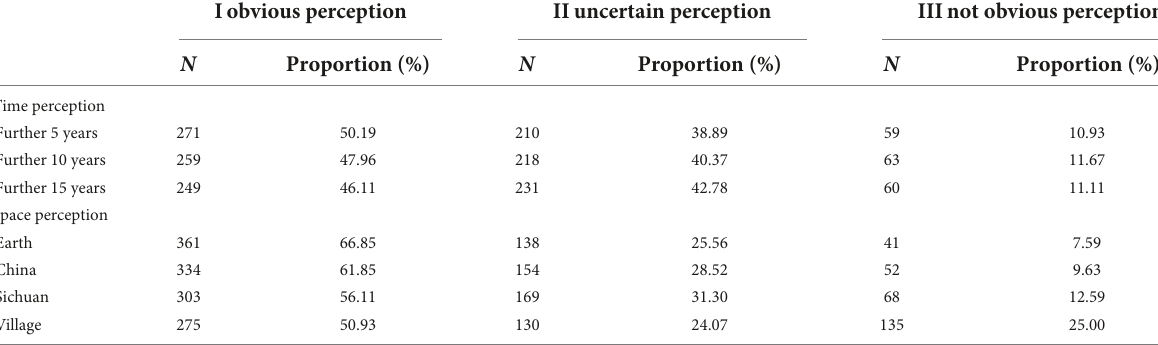
TABLE 6 Statistical table of farmers’ perception of climate change in time and